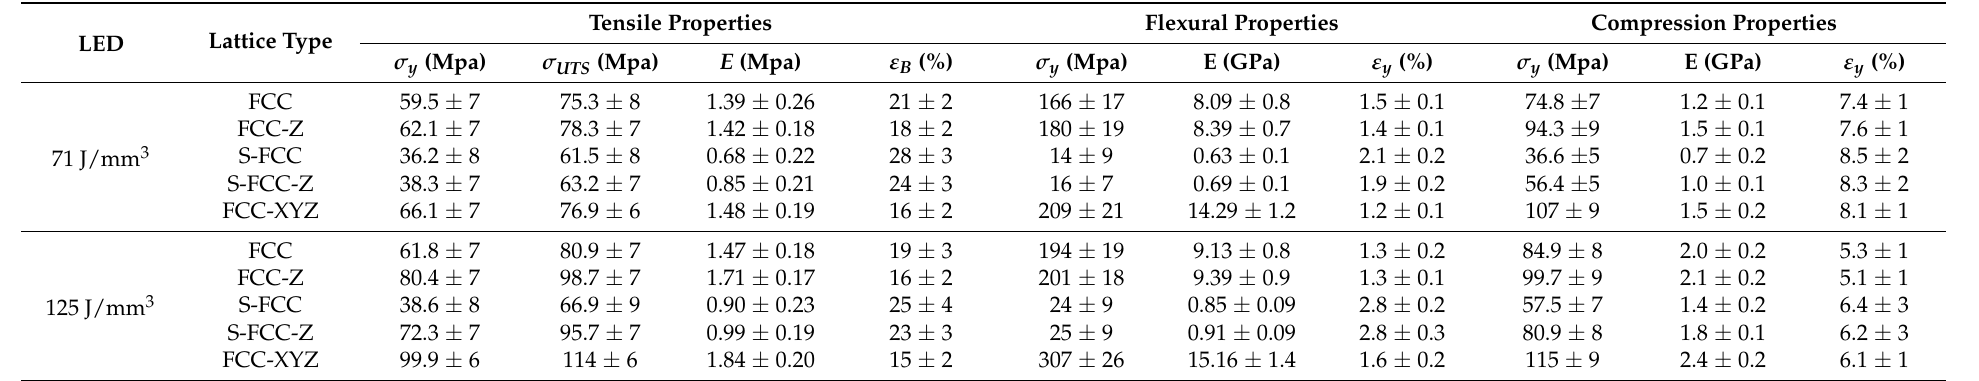
Table 5. The mechanical properties of lattice